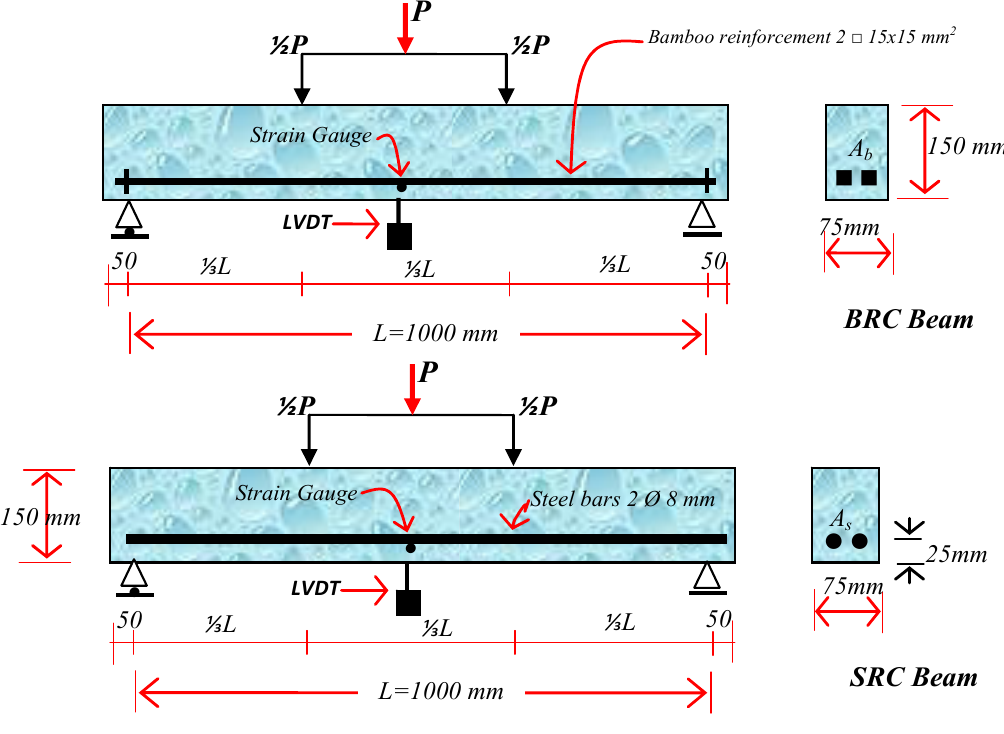
Figure 2. Reinforcement details and beam test settings.